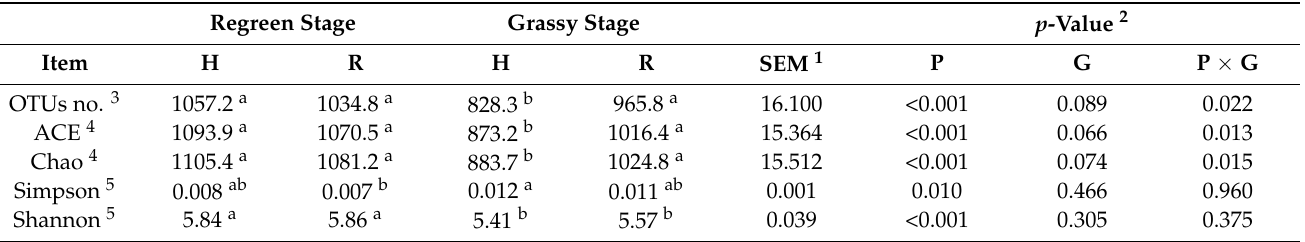
Figure 1. Analysis of similarity of rumen bacteria diversity based on Bray–Curtis distance. HR, hoggets of grazing Alpine Merino sheep in the regreen stage; RR, rams of grazing Alpine Merino sheep in the regreen stage, HG, hoggets of grazing Alpine Merino sheep in the grassy stage; RG, rams of grazing Alpine Merino sheep in the grassy stage. Table 1. Alpha-diversity indices of rumen microbiome of hoggets (H) and rams (R) of grazing Alpine Merino sheep under different phonological periods.